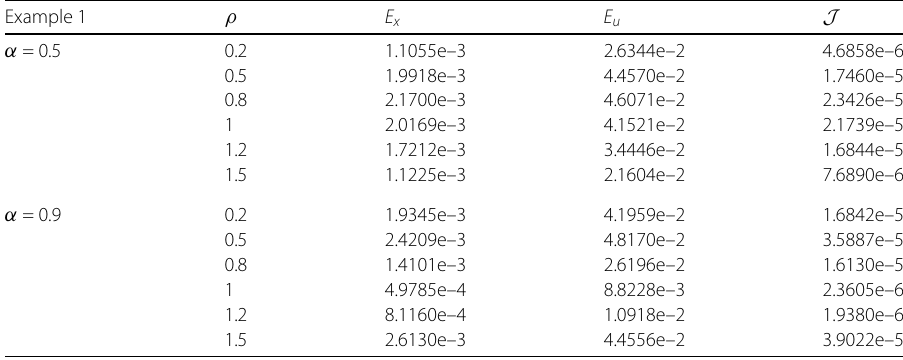
Table 3 The maximum absolute errors E x and E u at N = 5 and various values of α , ρ for x ( t ) and u ( t ), respectively Example 1 ρ E x E u J α = 0.5